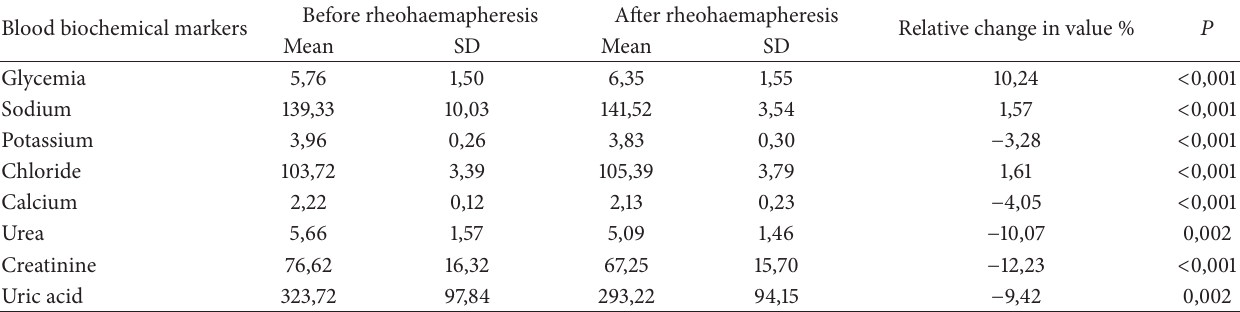
Table 2: The blood biochemical results before the procedures and immediately after the procedures. Before Blood biochemical markers